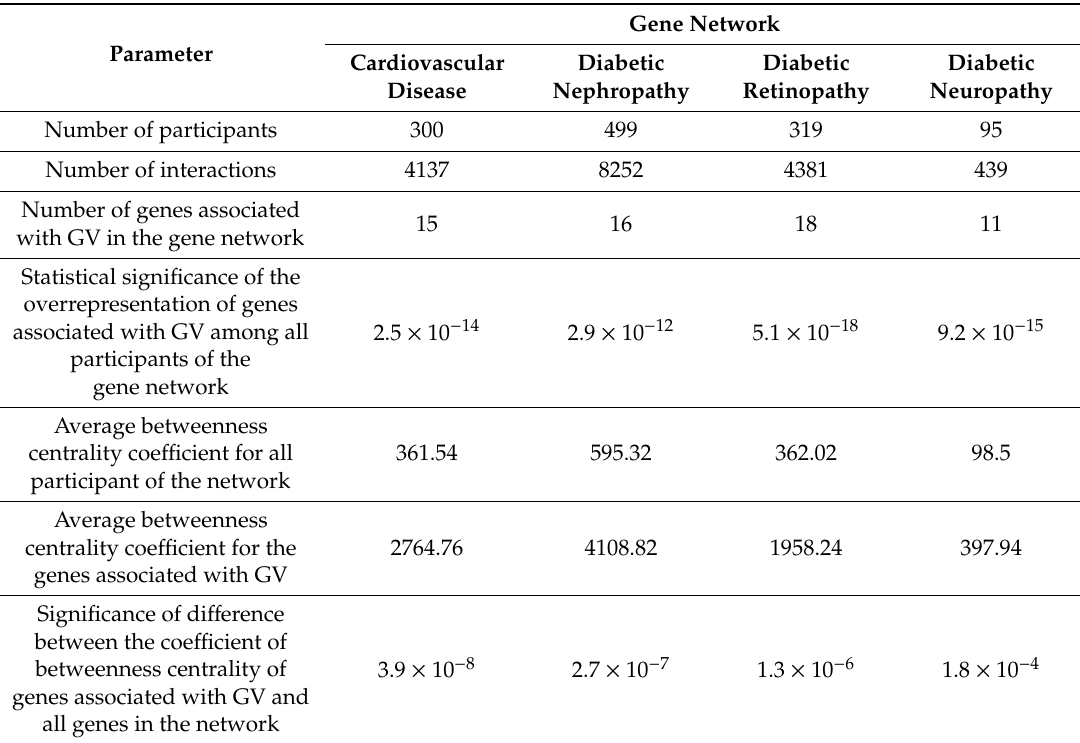
Table 3. Characterization of gene networks of the diabetes complications, taking into account the coe ffi cients of betweenness centrality of their